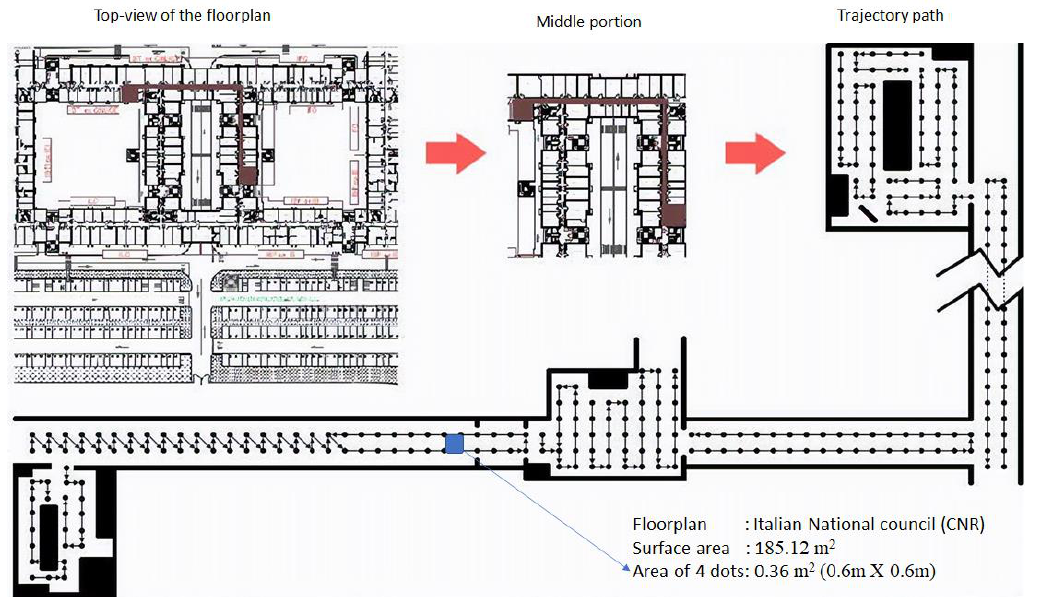
Figure 3. Indoor Floorplan with the top view and trajectory path from iPIN2016 [38].